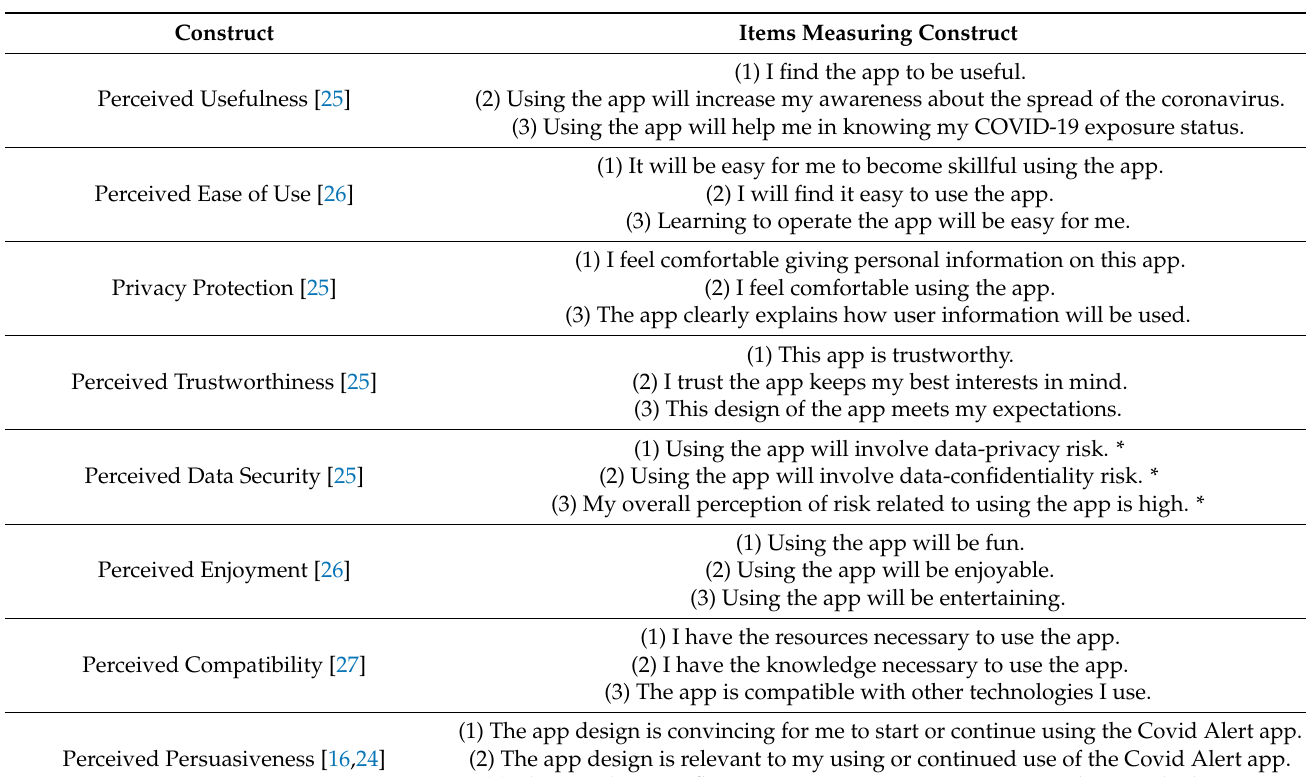
Table 2. Measurement instruments. * Item reversed during data analysis. The asterisked (*) items were reversed during data